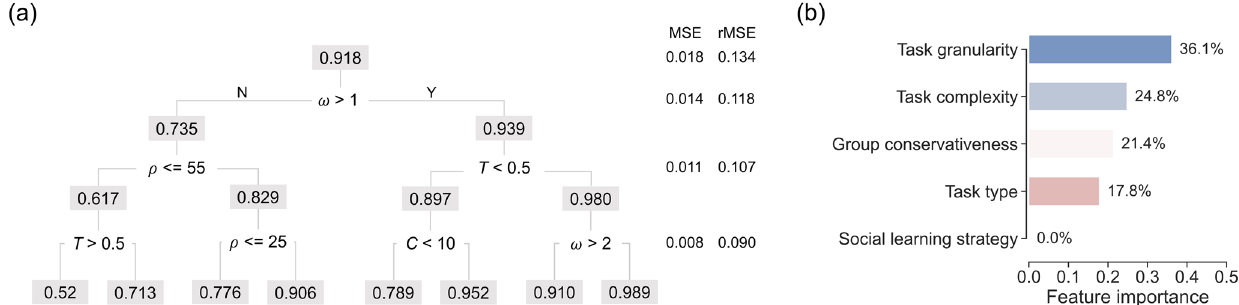
Fig. 5 The results of decision tree models learned on the simulation data. a A four-layer binary regression tree given by CART. Each gray box with the below conditional statement is a root node; these gray boxes without conditional statements are leaf nodes. The number in the gray box denotes the predicted value of group performance, and the conditional statement below the gray box represents the split point on a variable. N (the left of the conditional statement) and Y (the right of the conditional statement) represent No and Yes, respectively. For simplicity, N and Y are omitted next to other conditional statements. b Feature importance scores given by Random